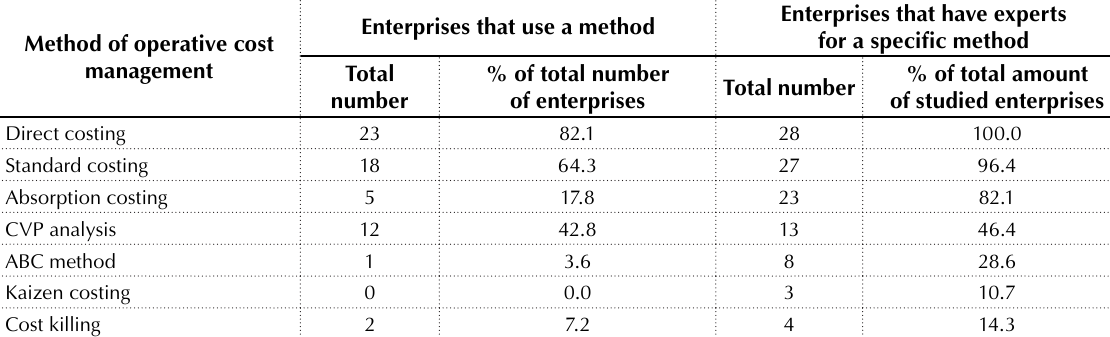
Table 7. Use of methods of operational cost management at the enterprises of Ukraine Method of operative